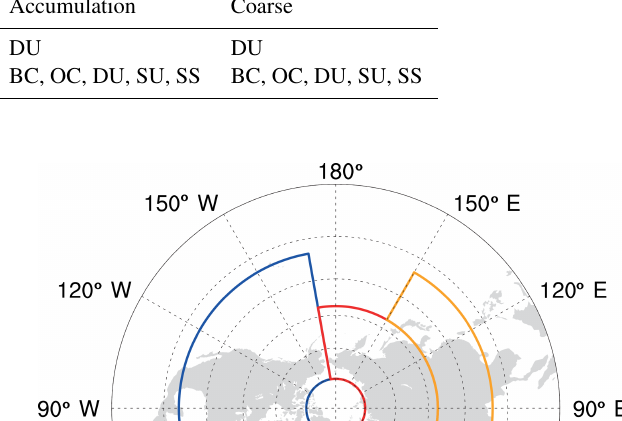
Table 1. Aerosol modes of the species in ECHAM-HAM, including organic carbon (OC), sulfate (SU), mineral dust (DU) and sea salt (SS) Nucleation Aitken Accumulation Coarse Hydrophobic BC, OC DU DU Hydrophilic SU BC, OC, SU BC, OC, DU, SU, SS BC, OC, DU, SU, SS